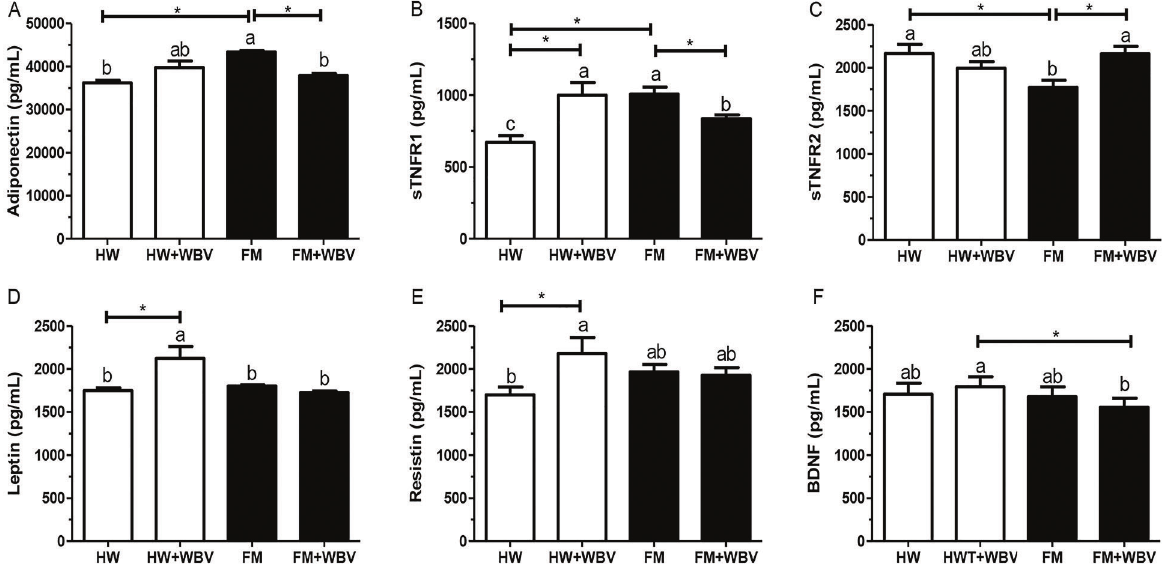
Figure 3. Effect of acute session of whole body vibration (WBV) on plasma levels of adiponectin ( A ), soluble tumor necrosis factor- receptors 1 (sTNFR1) ( B ) and 2 (sTNFR2) ( C ), leptin ( D ), resistin ( E ), and brain-derived neurotrophic factor (BDNF) ( F) in healthy women (HW; n=19) and in fi bromyalgia women (FM; n=19). Data are reported as means ± SE. P o 0.05, different small letters and asterisks indicate signi fi cant differences (Tukey ’ s